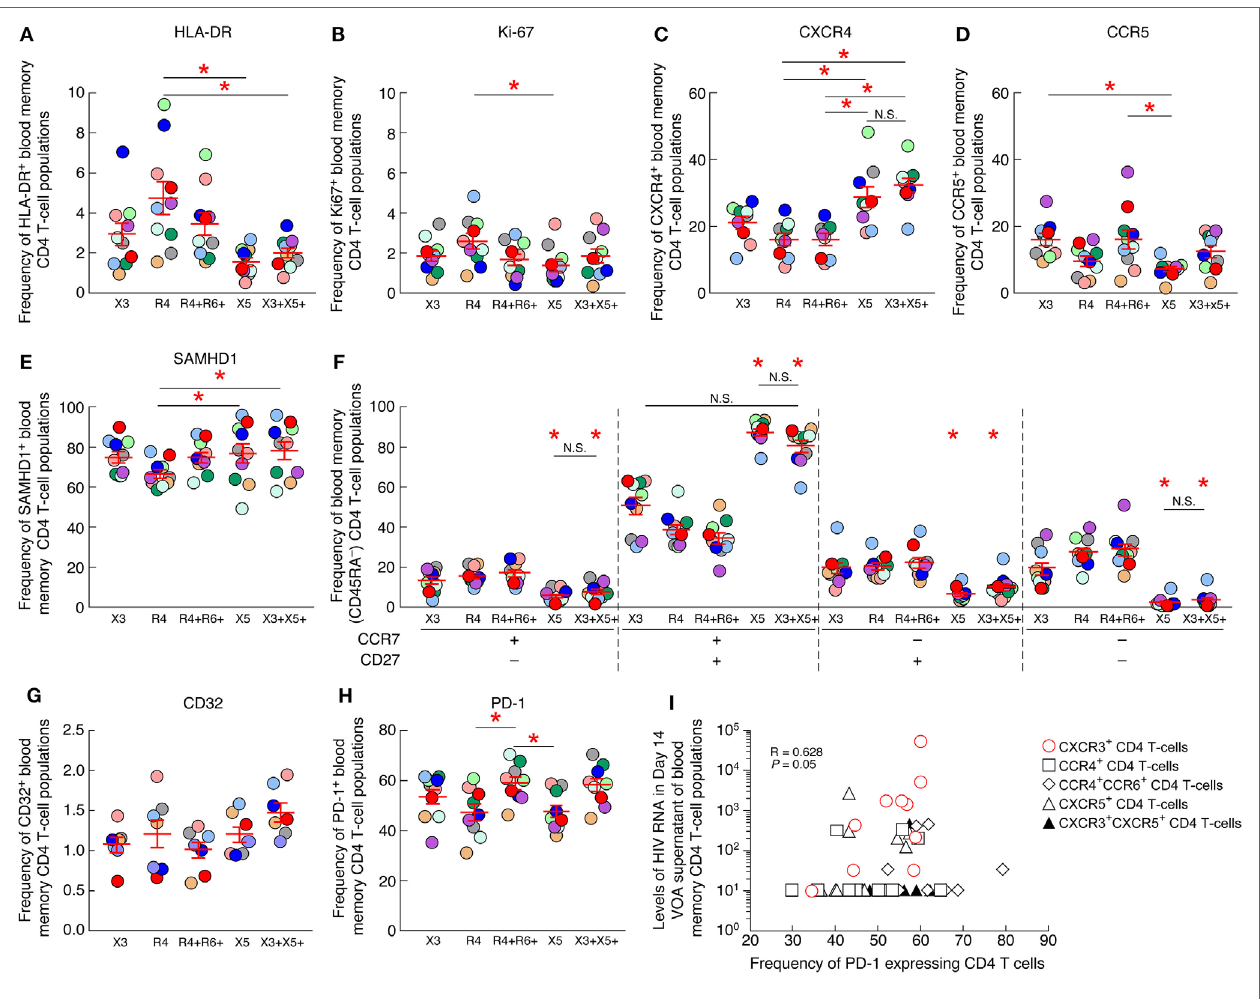
FigUre 6 | PD-1 expression on blood CXCR3 + CD4 T cells positively correlates with the levels of HIV-1 RNA produced in the virus outgrowth assay (VOA) culture supernatants. Percentage of expression of HLA-DR (a) , Ki-67 (B) , CXCR4 (c) , CCR5 (D) , SAMHD1 (e) on chemokine receptor expressing blood memory (CD45RA − ) CD4 T-cell populations isolated from aviremic long-term-treated HIV-1-infected individuals ( N = 10). (F) Differentiation profile of chemokine receptor expressing blood memory (CD45RA − ) CD4 T-cell populations isolated from aviremic long-term-treated HIV-1-infected individuals ( N = 10). Percentage of CD32 + ( N = 7) (g) or PD-1 + ( N = 10) (h) chemokine receptor expressing blood memory (CD45RA − ) CD4 T-cell populations isolated from aviremic long-term-treated HIV-1-infected individuals. (i) Correlation between HIV-1 RNA levels detected in day 14 VOA supernatants of chemokine receptor expressing blood memory CD4 T-cell populations and the percentage of PD-1-expressing CD4 T cells within each chemokine receptor expressing blood memory CD4 T-cell population. Undetectable values were arbitrarily defined as 10 HIV-1 RNA copies/mL (i) . Red bars correspond to SEM (a–h) . “X3” corresponds to blood CXCR3-expressing CD4 T cells; “R4” corresponds to blood CCR4-expressing CD4 T cells; R4 + R6 + corresponds to blood CCR4 + CCR6 + CD4 T cells; “X5” corresponds to blood CXCR5-expressing CD4 T cells; And X3 + X5 + corresponds to blood CXCR3 + CXCR5 + CD4 T cells. Each HIV-infected individual was color coded (a–h) . Red stars indicate statistical significance ( P < 0.05) (a–h) . Statistical significance ( P -values) was either obtained using one-way ANOVA (Kruskal–Wallis test) followed by Wilcoxon matched-pairs two-tailed signed rank test (a–h) or Spearman rank test for correlation (i)